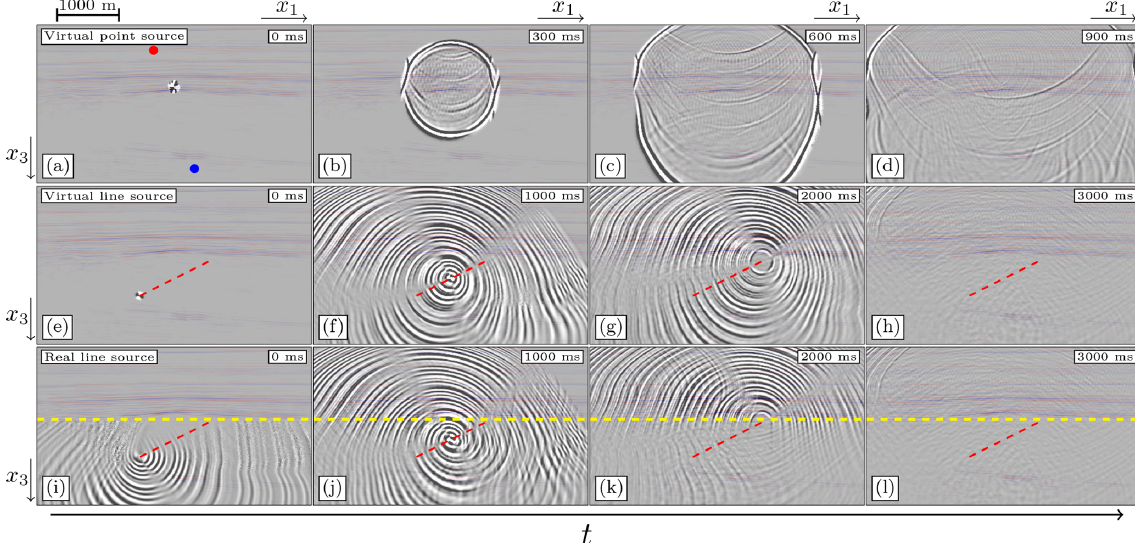
Figure 12. Snapshots of the wave field inside the white box in Fig. 11 for the field data. (a–d) Homogeneous wave field in the subsurface, retrieved for virtual receivers and a virtual double-couple source inclined at − 20 ◦ using Eq. (19). (e–h) Similar to (a–d) for a line source of double-couple sources with random amplitudes inclined at − 22 . 4 ◦ using Eq. (21). (i–l) Similar to (e–h) using a superposition of double- couple sources with random amplitudes using Eq. (22). The yellow line indicates the border between the area below and above the shallowest source. The images are overlain with the image of the subsurface from Fig. 11b. All wave fields had their source wavelets reshaped to a 30Hz Ricker wavelet.